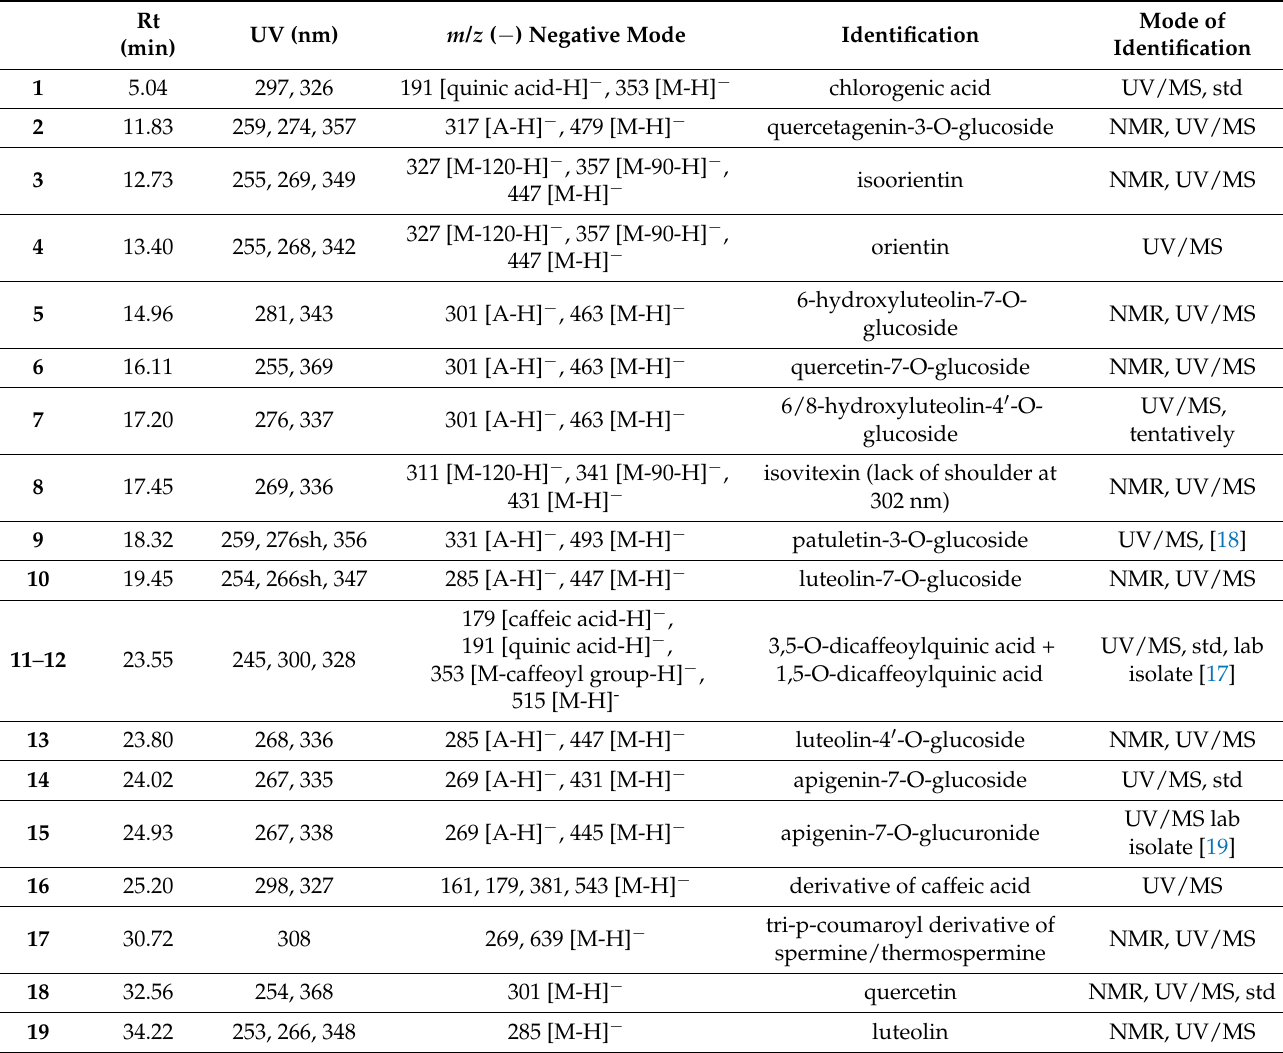
Table 1. MS fragmentation and UV–vis absorption data of the compounds detected in the MeOH extract of Matricaria pubescens